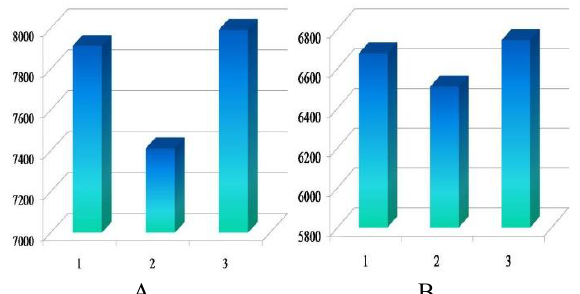
Fig. 2. Comparative data regarding daily sums of energy in 3 cases: changing excitation coefficient (tracking) ( c var ) (a), averaged coefficient c selected optimally for a specific interval (b), energy gained from PV conversion (c). Clarifications: time 1.06, PV AEG PQ 40/50 battery, spatial orientation of the battery : angle of inclination to the ground  = 13  , azimuth angle  = 2  , for case A: T = 25  C, for case B: T = 50 